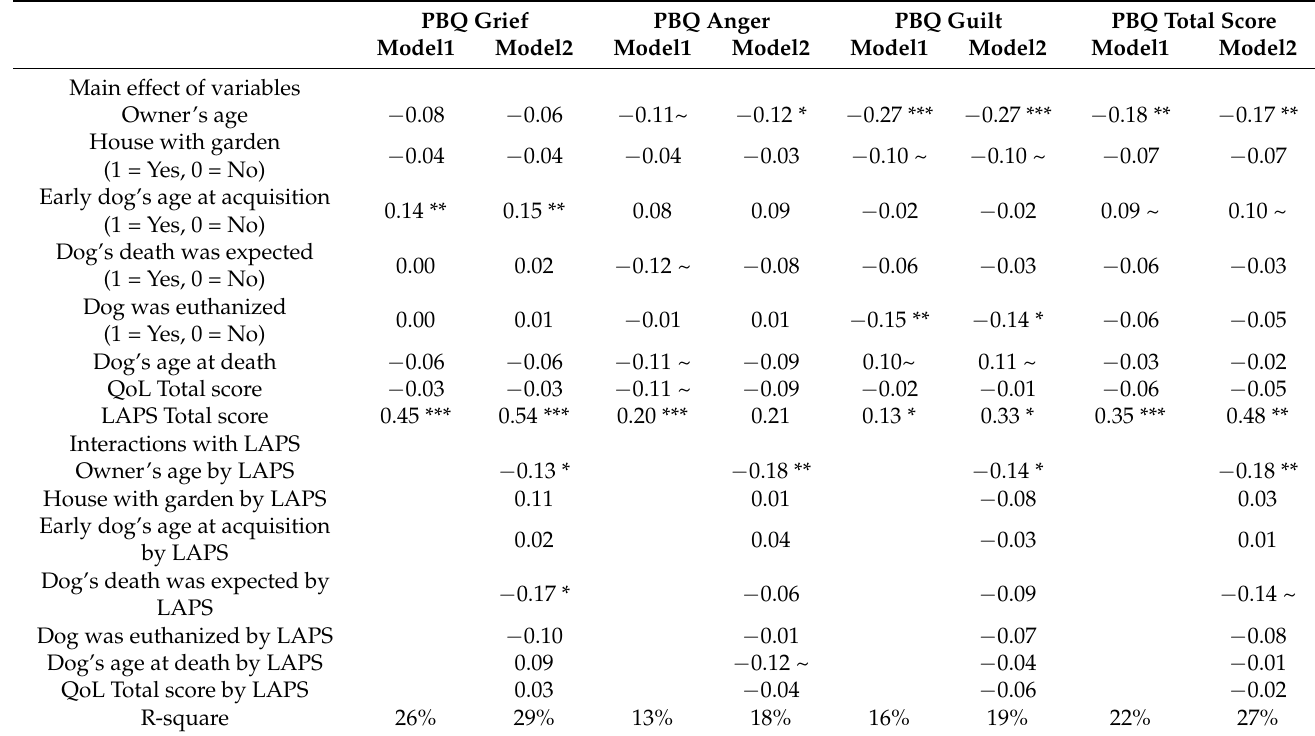
Table 3. Regression analysis results for the